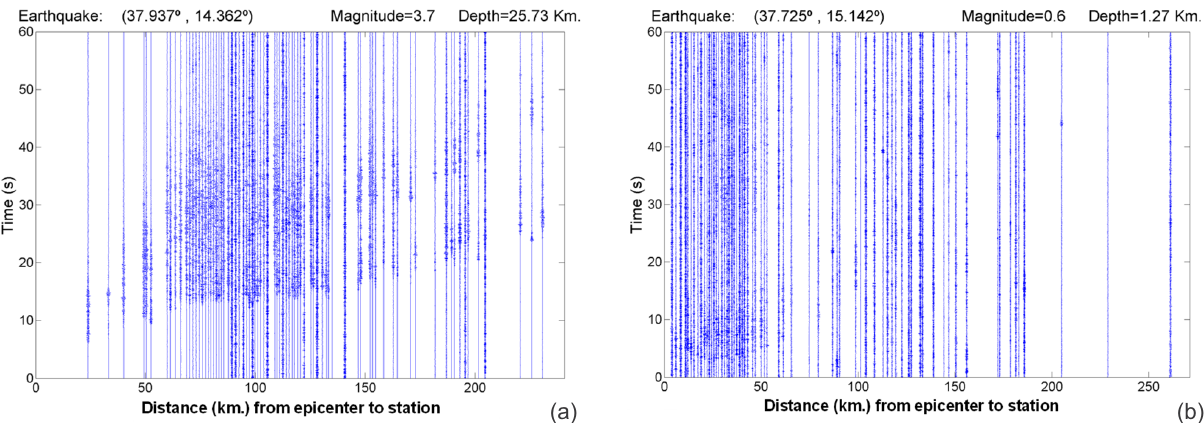
Figure 5. (a) An example of an earthquake of magnitude 3.7 and focal depth of around 26 km. We plot a seismogram 60 seconds long recorded in 78 seismic stations and ordered by increasing epicentral distance. (b) Same for an earthquake of magnitude 0.6 and focal depth of 1.3